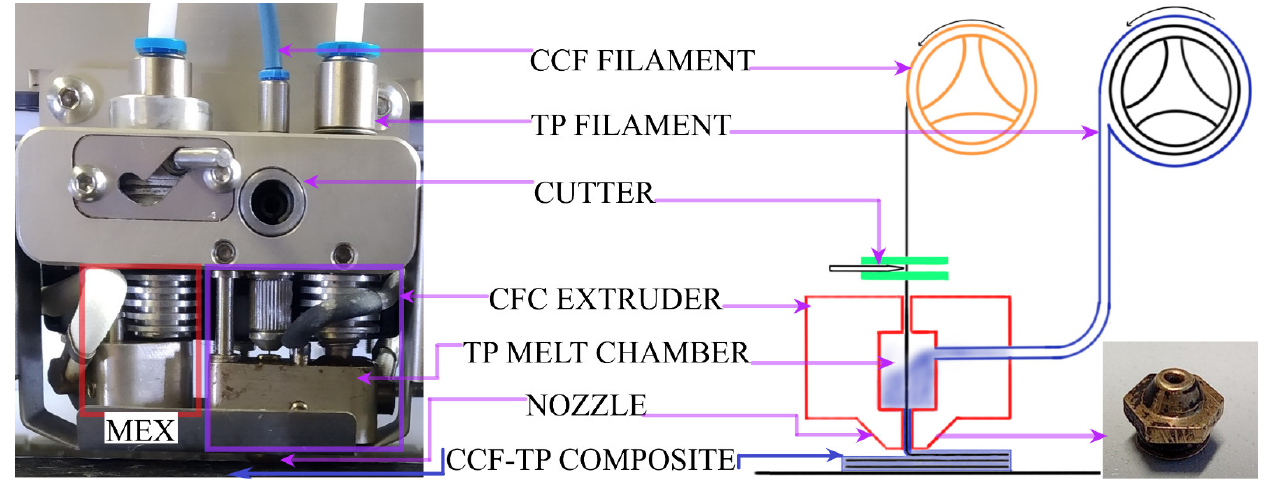
Figure 1. MEX and CFC print head photography and schematics of Composer A4 CFC print head. The photography shows two print heads, a typical MEX print head for plastic printing (red box) and a CFC print head (purple box) for composite printing. Table 4. Important printing